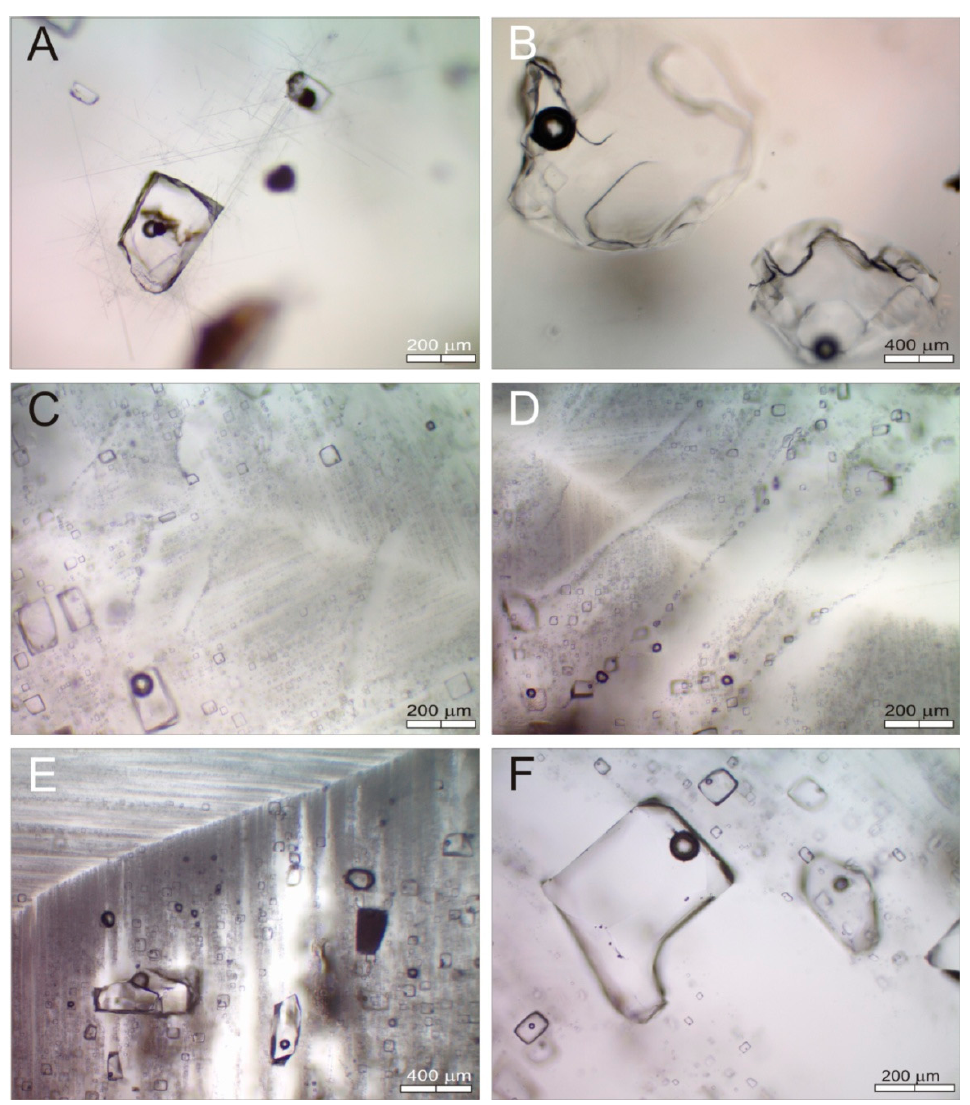
Figure 3. Secondary fluid inclusions. ( A ) fluid inclusions within transparent recrystallized halite from the Forecarpathian Basin, Badenian, sample no. H-III-70; ( B ) from the Ordos Basin, Ordovician, Well K-1, depth: 2385.5 m; ( C – F ) secondary fluid inclusions within sedimentary halite from the Transcarpathian Basin, Badenian, Well 6-T, interval depths: ( C )—1075–1078 m; ( D )—1168–1179 m; ( E , F ) 1087–1090 m.